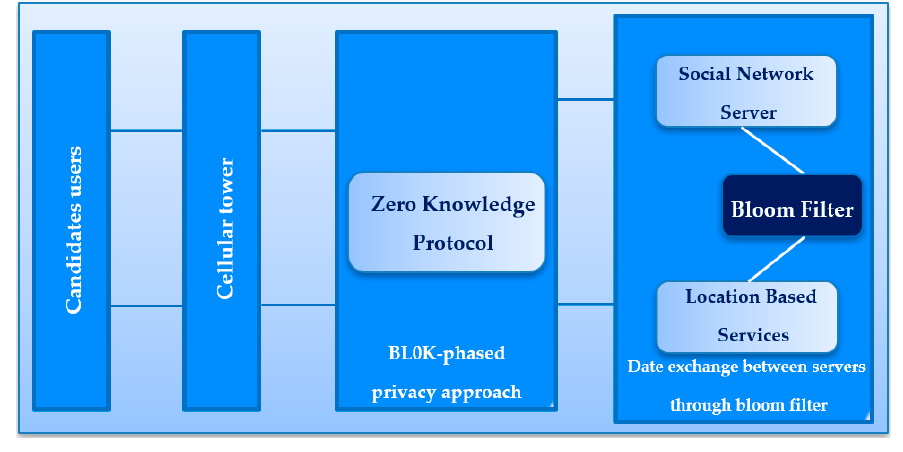
Figure 4. The overview of BL0K in LBS.